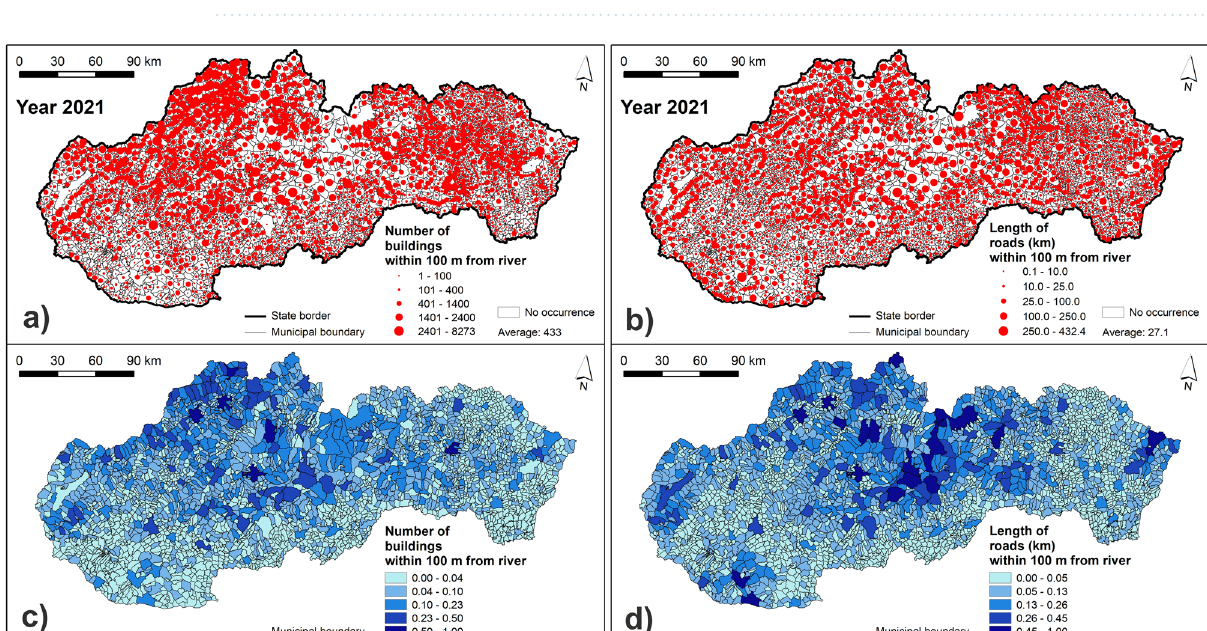
Figure 7. Indicators of the number of buildings and length of roads within 100 m from a river: ( a ) original values of the number of buildings within 100 m from a river; ( b ) original values of the length of roads within 100 m from river; ( c ) normalized values of the number of buildings within 100 m from a river; ( d ) normalized values of the length of roads within 100 m from a river. This figure was generated in ArcGIS 10.2.2